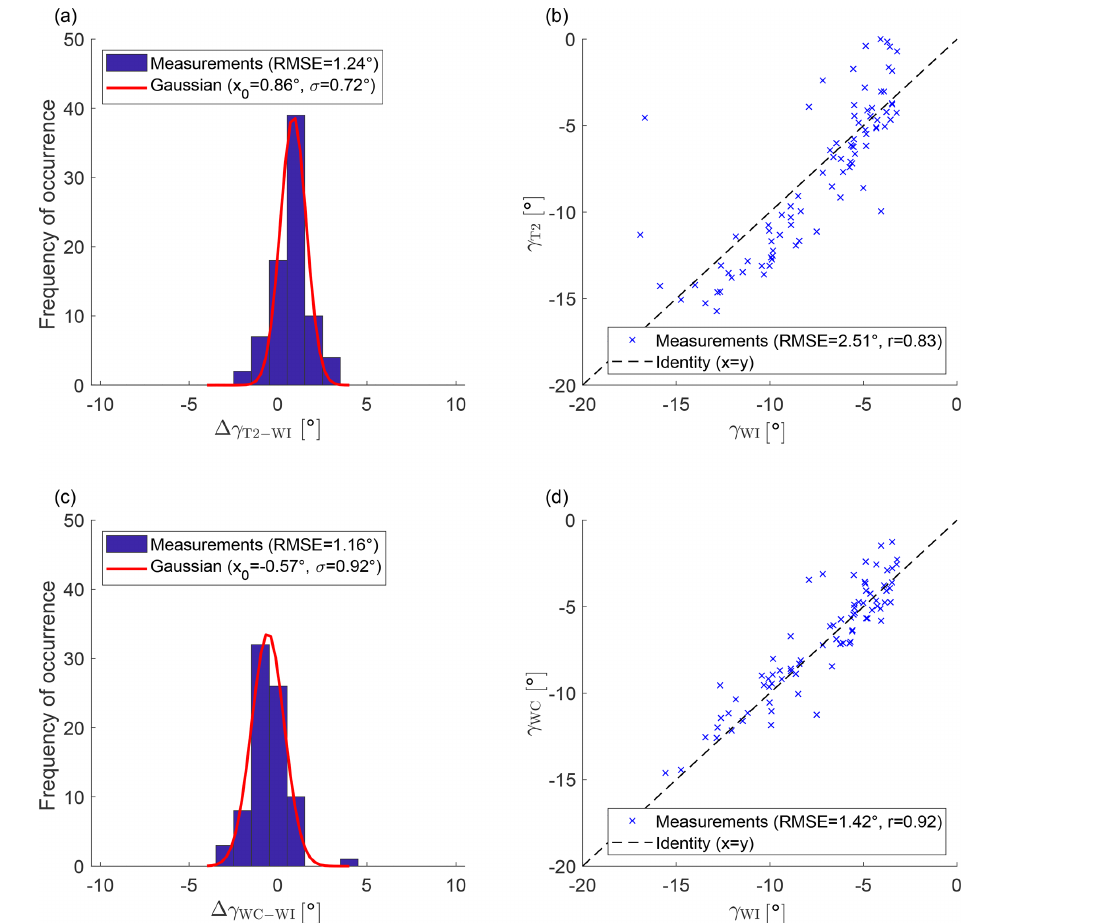
Figure 7. Inter-comparison of the yaw angle measurements. Panel (a) shows a histogram of the yaw angle difference between the WindIris and the SCADA data of T2 for the control cases. Panel (b) shows the yaw angle from the SCADA data of T2 and the WindIris for wake- steering cases. Panel (c) shows a histogram of the yaw angle difference between the WindCube and the WindIris for the control cases. Panel (d) shows the yaw angle from the SCADA data of T2 and the WindIris for wake-steering cases. The red line shows a Gaussian fit to the histogram, and the dashed black line is the identity. The data were filtered according to Sect. 2.3.1, but for (a) and (c) the yaw angle limitation was omitted.